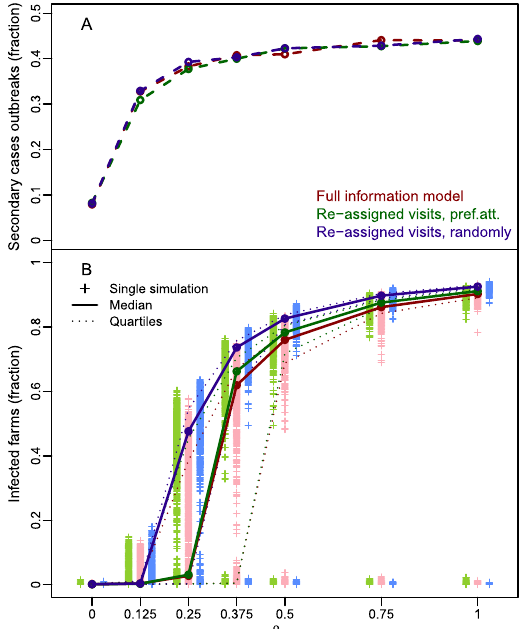
Figure 6. Epidemic simulations with preferential attachment visits assignment. Results of the simulations comparing the full-information model (magenta), and two alternative set of simulations. We assigned the on- farm visits to veterinarians randomly (blue) and following a preferential attachment criteria (green). Panel (A) dashed lines represent the fraction of epidemics with secondary cases. Panel (B) the distribution of the number of infected farms (crosses), with the median (thick line), and the 25 th and 75 th quantiles (dotted